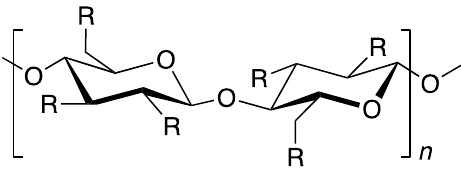
Figure 1. Molecular structure of the cellulose backbone for various cellulose ethers: cellulose, R=OH; MC, R=OH or CH 3 ; HEC, R=OH or CH 2 CH 2 OH; CMC, R=OH or CH 2 COONa; HPC, R=OH